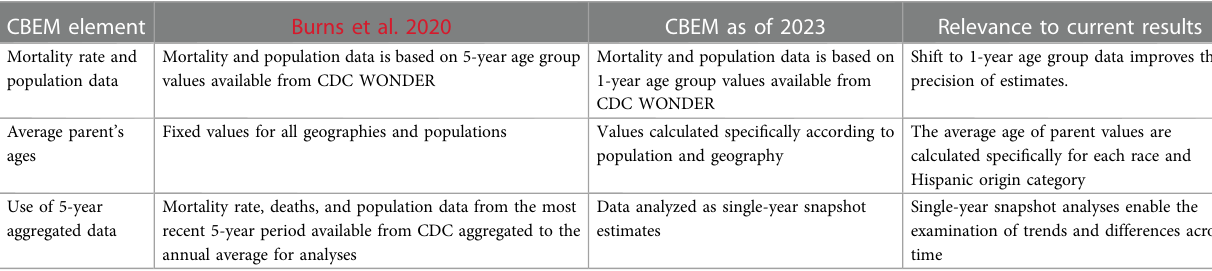
TABLE 1 Review of CBEM ’ s parental bereavement elements and updates. CBEM